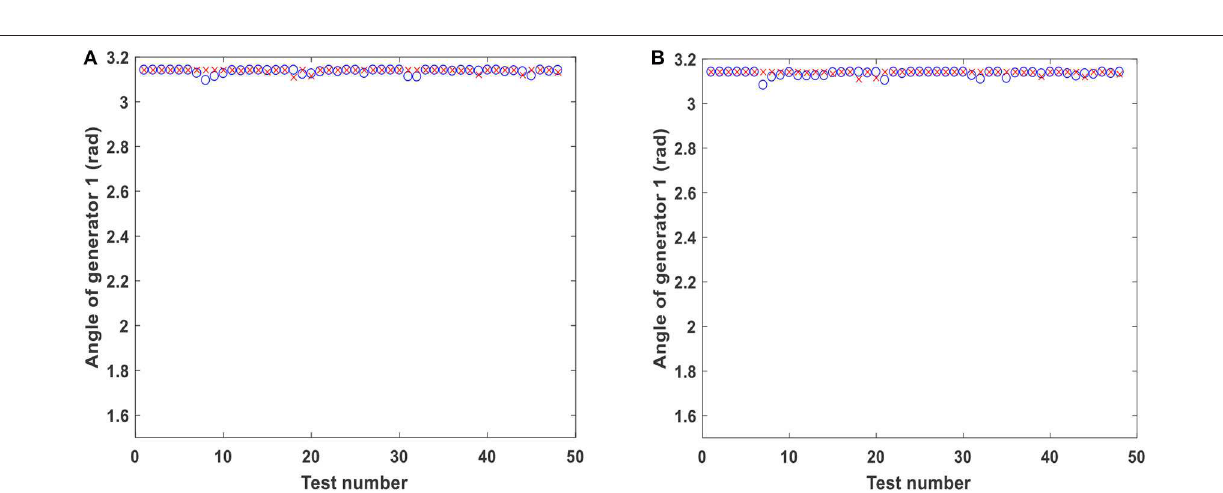
Frontiers in Energy Research |